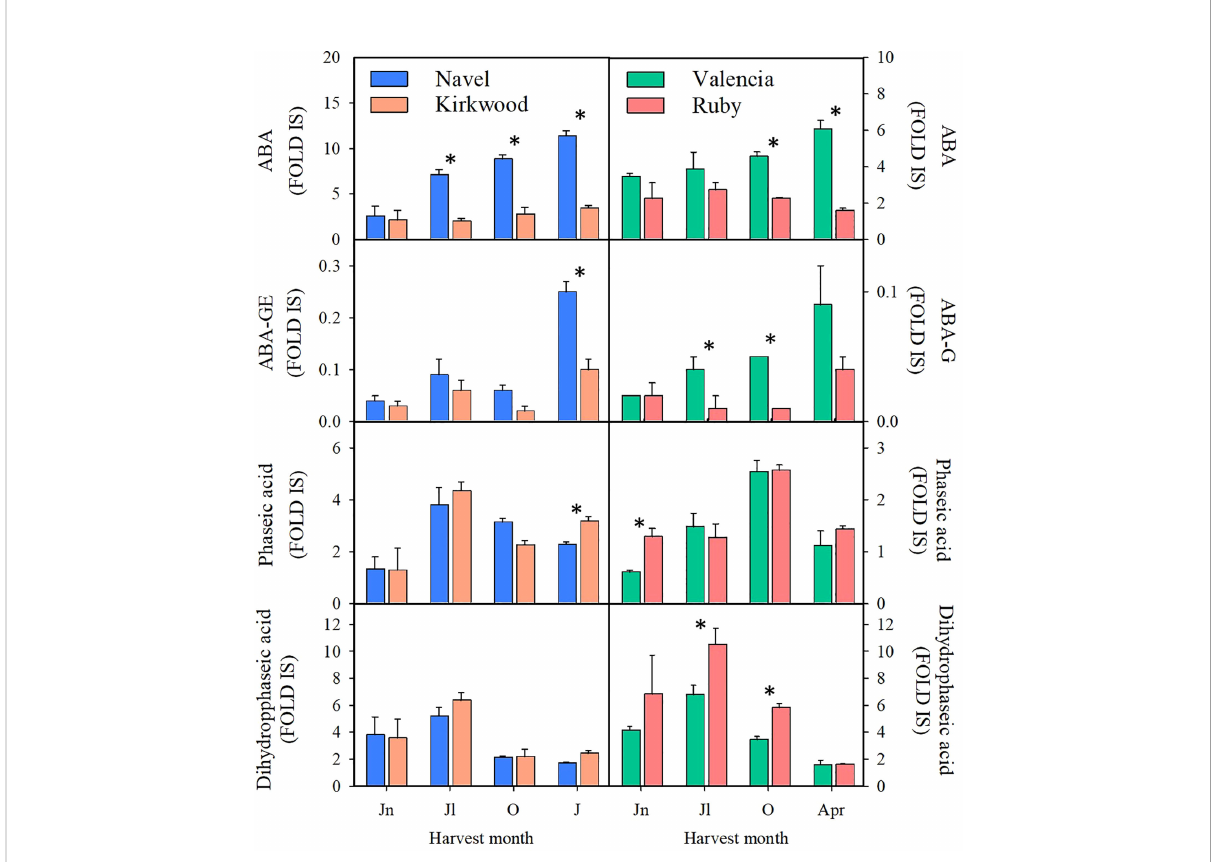
FIGURE 7 Content of abscisic acid (ABA), abscisic acid glucose ester (ABA-GE), phaseic acid and dihydrophaseic acid (Fold Internal Standard) in the pulp of Navel and Kirkwood (left panels) and Valencia and Ruby (right panels) during fruit development and maturation. Jn, June; Jl, July; O, October; J, January; Apr, April. Data are the mean of three biological replicates ± SD. Asterisks indicate signi fi cant differences between Kirkwood and Ruby and their respective standard varieties by unpaired Student ’ s t-test (p <